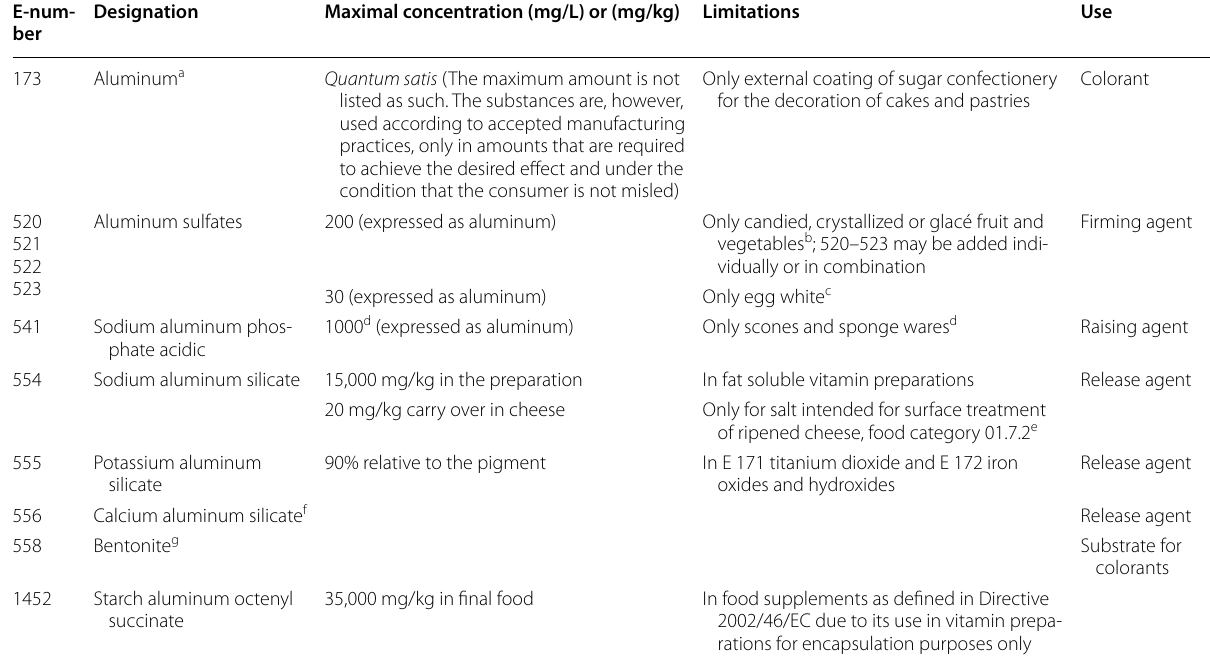
Table 4 Food additives containing or consisting of aluminum, according to the Austrian Federal Ministry of Health